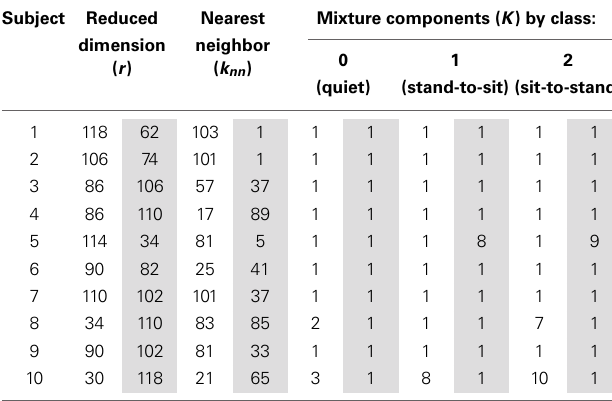
The table indicates optimal parameter set for the triggered (white background) and self-initiated (shaded background)